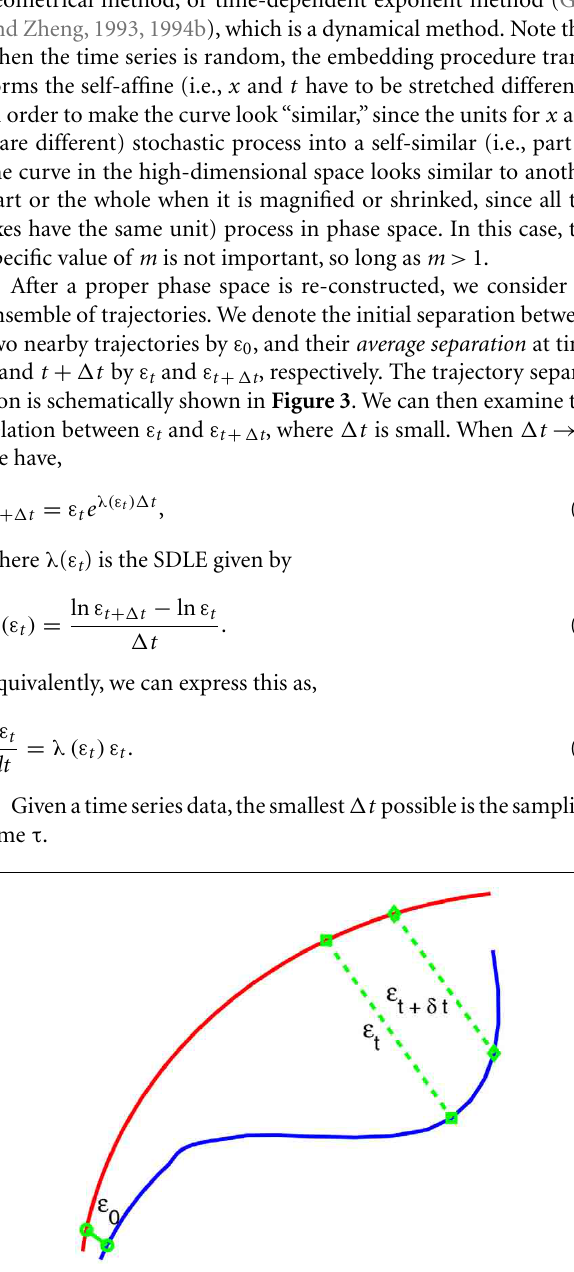
FIGURE 3 |A schematic showing 2 arbitrary trajectories in a general high-dimensional space, with the distance between them at time 0, t , and t + δ t being ε 0, ε t , and ε t + δ t ,